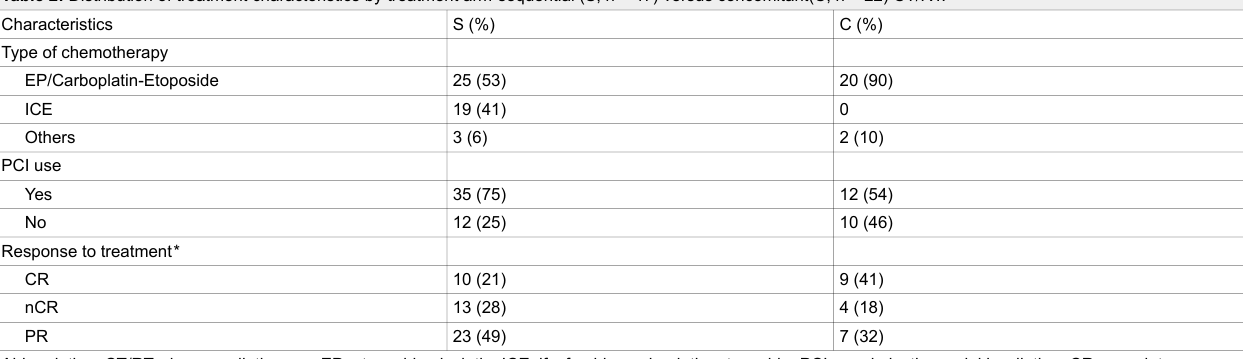
Abbreviation: CT/RT: chemo-radiotherapy; EP: etoposide-cisplatin; ICE: ifosfamide, carboplatin, etoposide; PCI: prophylactic cranial irradiation; CR: complete response; nCR: near complete response; PR: partial response; *data missing in 3